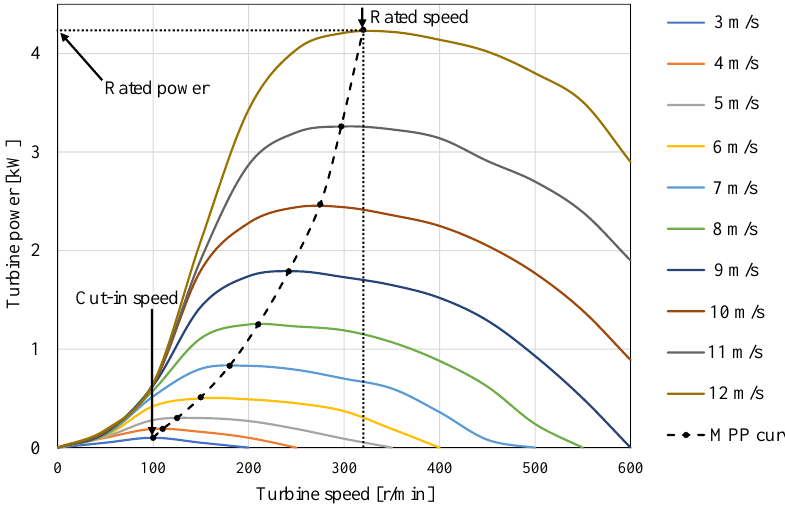
Figure 2. Turbine power versus turbine speed, with the wind speed as a